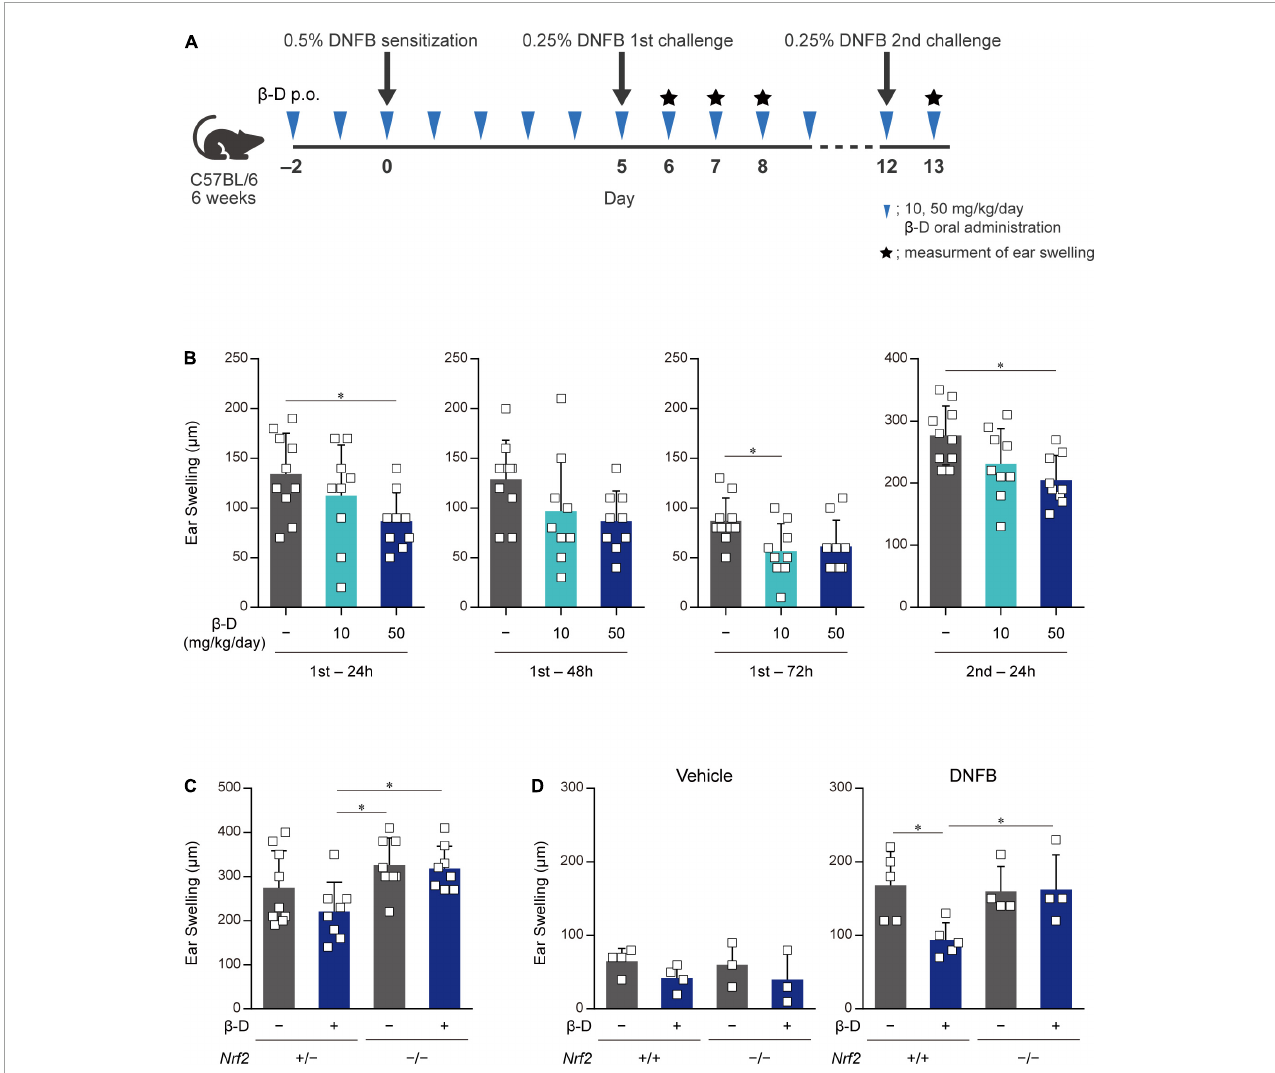
FIGURE5 Orally administered β -damascone ameliorated the pathology of CHS. (A) Schematic of the oral administration schedule of β -damascone in the DNFB-induced CHS model. The indicated amounts of β -damascone in 200 µ l of saline were orally administered every day. p.o., per os . (B) Ear swelling in CHS-induced wild-type mice at the indicated time points. (C) Ear swelling in CHS-induced Nrf2 gene targeted mice 48 h after second challenge. (D) Ear swelling in Nrf2 + / + and Nrf2 − / − mice 48 h after DNFB challenge, with or without DNFB sensitization. Vehicle, without sensitization; DNFB, with sensitization. (Ear swelling) = (ear thickness after the challenge) – (ear thickness before the first challenge). The data represent the mean ± SD of individuals. The Tukey-Kramer test was used. ∗ p <